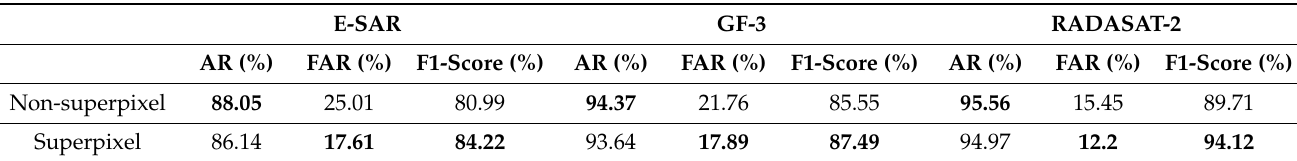
Table 6. Building extraction accuracy table using the superpixel